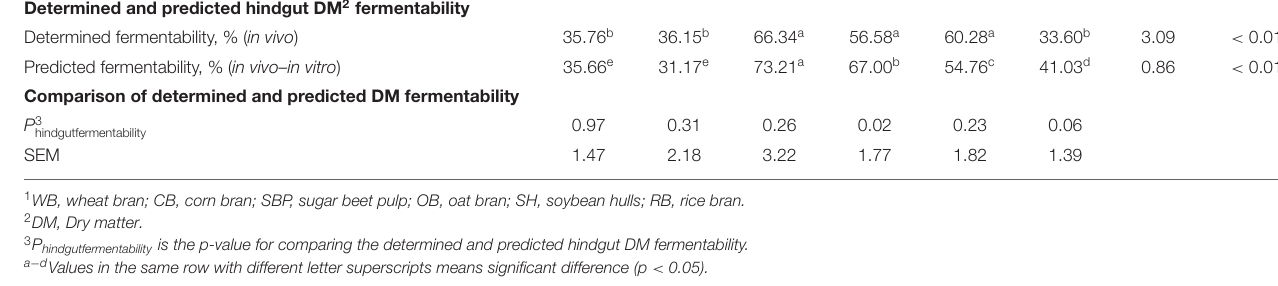
TABLE 5 | Determined and predicted hindgut DM fermentability for ileal cannulated pigs fed the diets with different sources of fiber ( n = 6 per group). Items Diets 1 WB CB SBP OB SH RB SEM 2 P